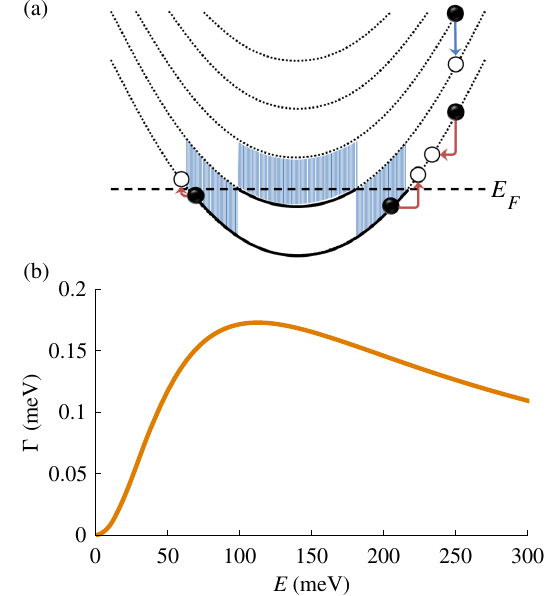
FIG. 4. Modeling the relaxation rate of a 1D electronic subband. (a) Schematic comparison of the slow three-body relaxation of hot electrons on the lowest subband, which excites both copropagating and counterpropagating electron-hole pairs, and the fast two-body relaxation of hot electrons on higher subbands (red and blue arrows, respectively). (b) The calculated relaxation rate of a single subband with quadratic dispersion. The dispersion was chosen to have the same Fermi momentum and Fermi velocity as the nanowire ’ s lowest